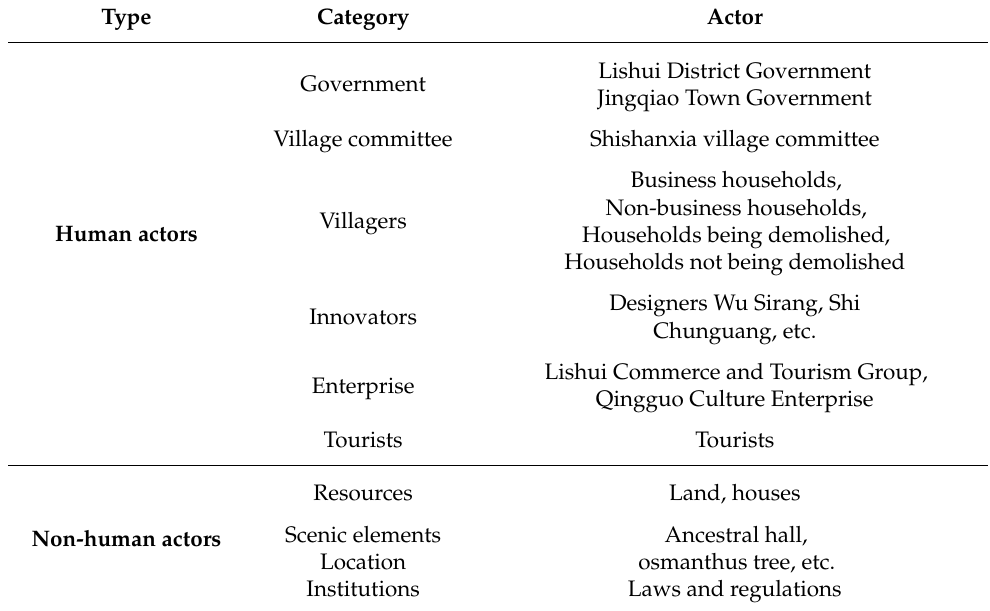
Table 2. Actors in the Shishanxia spatial reconstruction